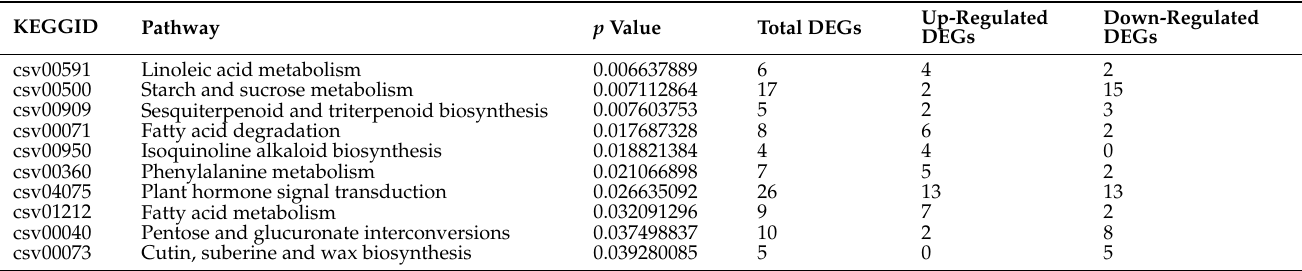
Table 1. Enriched KEGG pathways of the DEGs in ETH